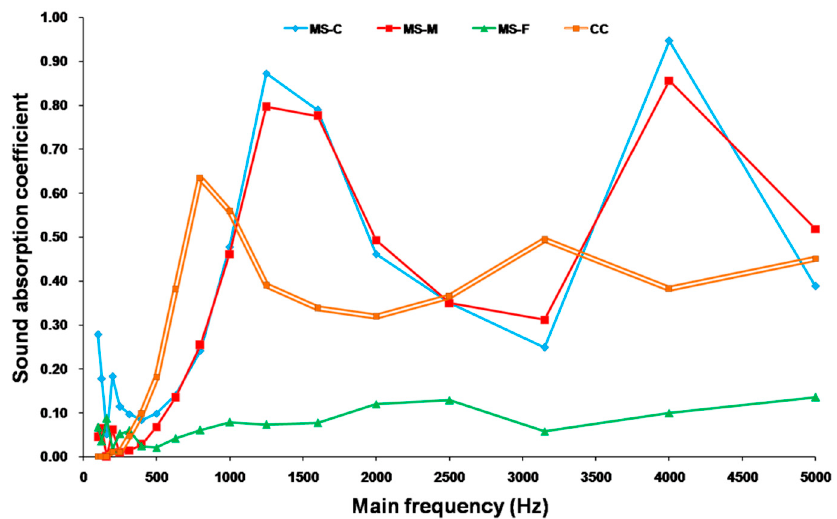
Figure 6. Sound absorption coefficients for noise barrier products made from the studied boiler slag compared with coarse porous cement (CC).